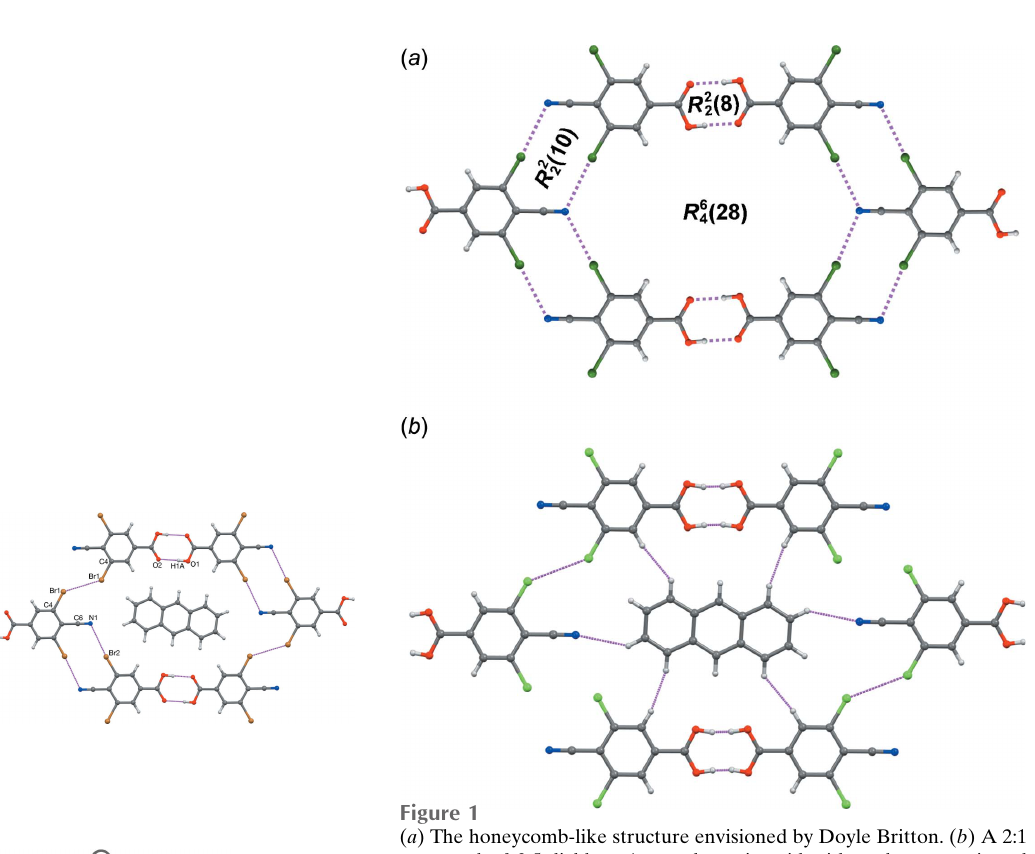
Figure 1 ( a ) The honeycomb-like structure envisioned by Doyle Britton. ( b ) A 2:1 co-crystal of 3,5-dichloro-4-cyanobenzoic acid with anthracene, viewed along 281 (Britton, 2012). Magenta dashed lines represent short